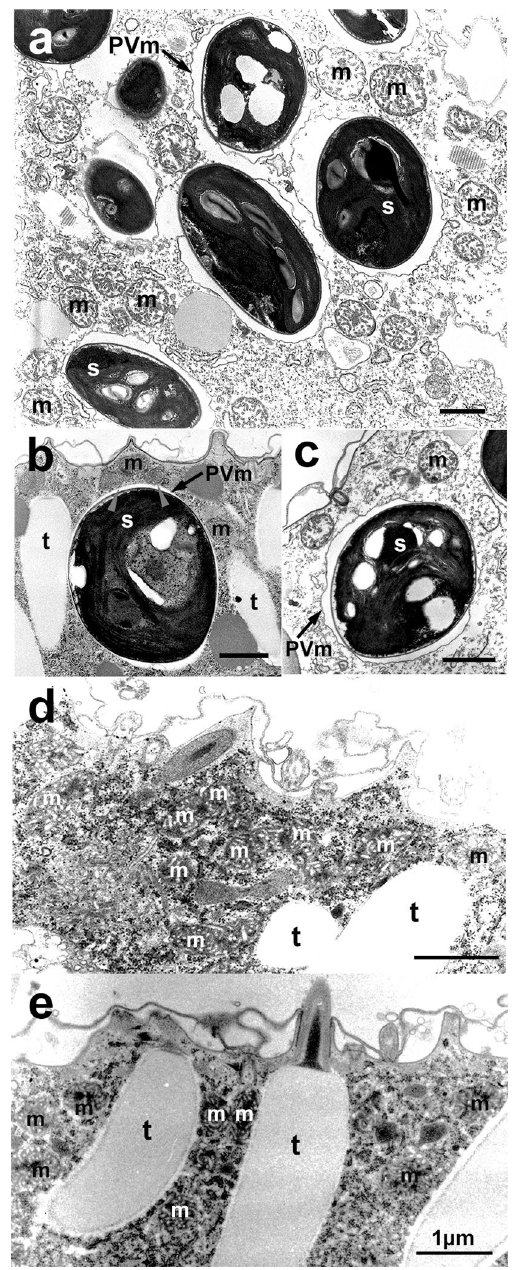
Figure 1. Transmission electron microscopic images of the cell cortex of algae-bearing ( a )–( c ) and alga-free ( d ) and ( e ) P. bursaria cells. ( a ) Host mitochondria surround the PV membrane wrapping the symbiotic alga (s). ( b ) Symbiotic alga between the trichocysts beneath the host cell cortex. ( c ) Both host trichocysts and mitochondria are very few around the symbiotic alga. Gray arrowheads in ( b ) indicate mitochondria attached to the PV membrane. Note that many mitochondria and trichocysts can be observed beneath the cell cortex in alga-free cells ( d ) and ( e ). t, trichocyst; m, mitochondrion; PVm, PV membrane; s, symbiotic alga. Bars = 1